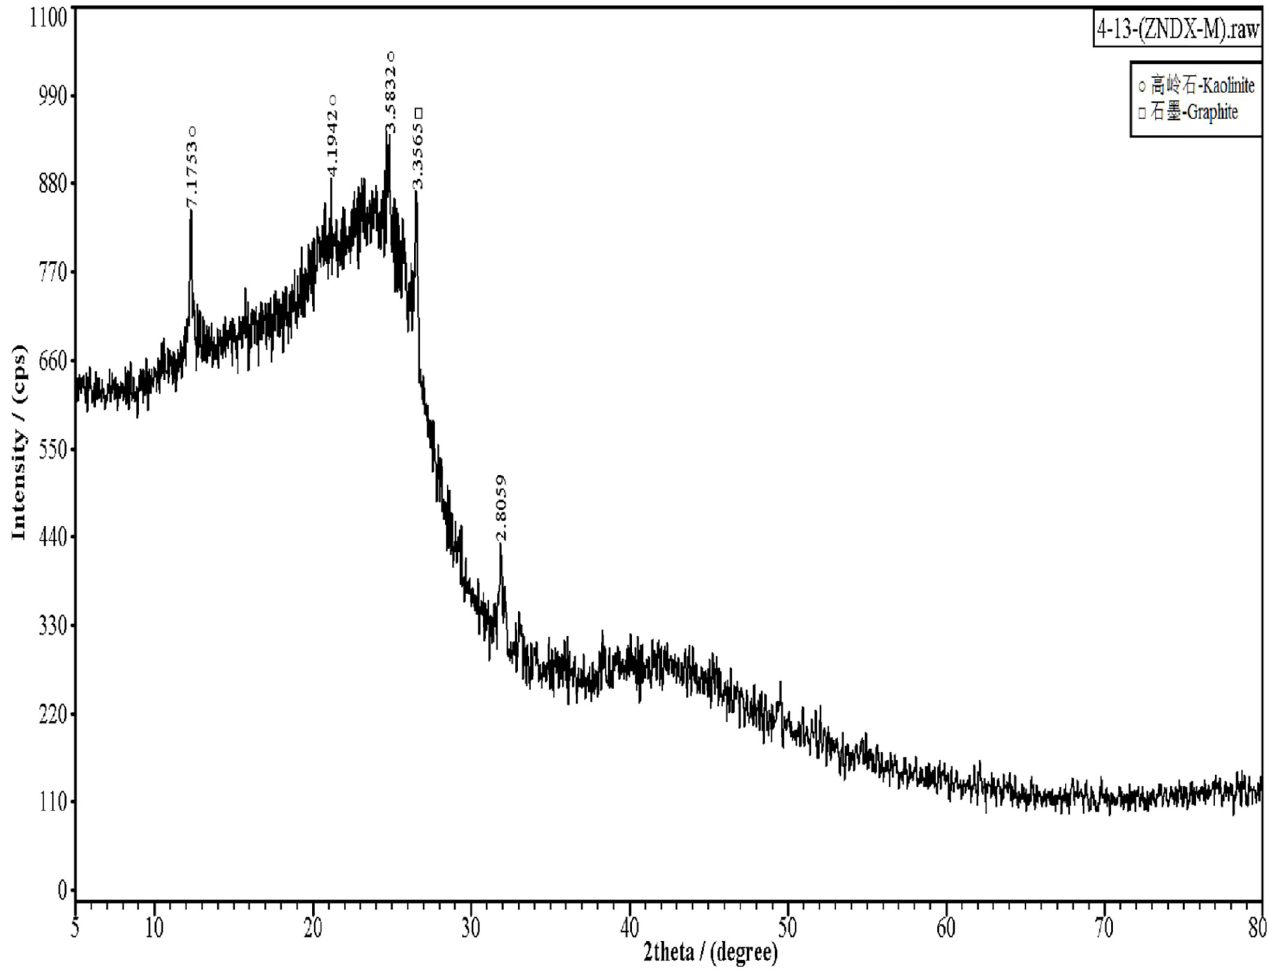
Fig 6. XRD spectra of coal